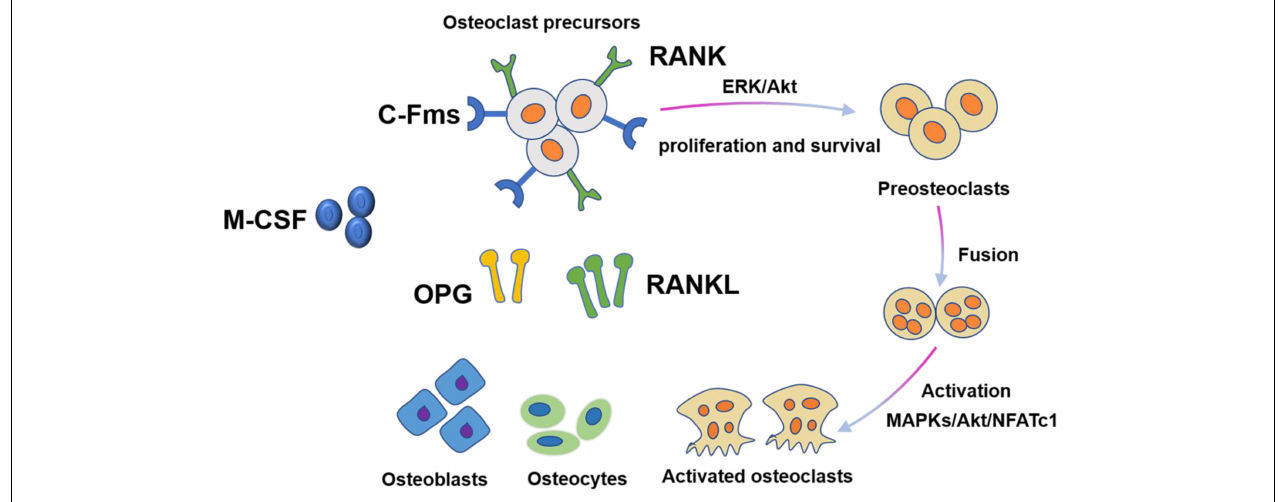
FIGURE 2 | Osteoclast differentiation is stimulated by M-CSF and RANKL. M-CSF induces the proliferation and survival of osteoclast precursor cells through activation of ERK and Akt. RANKL recruits TRAF6 to activate MAPKs, Akt, and NFATc1 to promote differentiation of osteoclast precursors to osteoclasts.